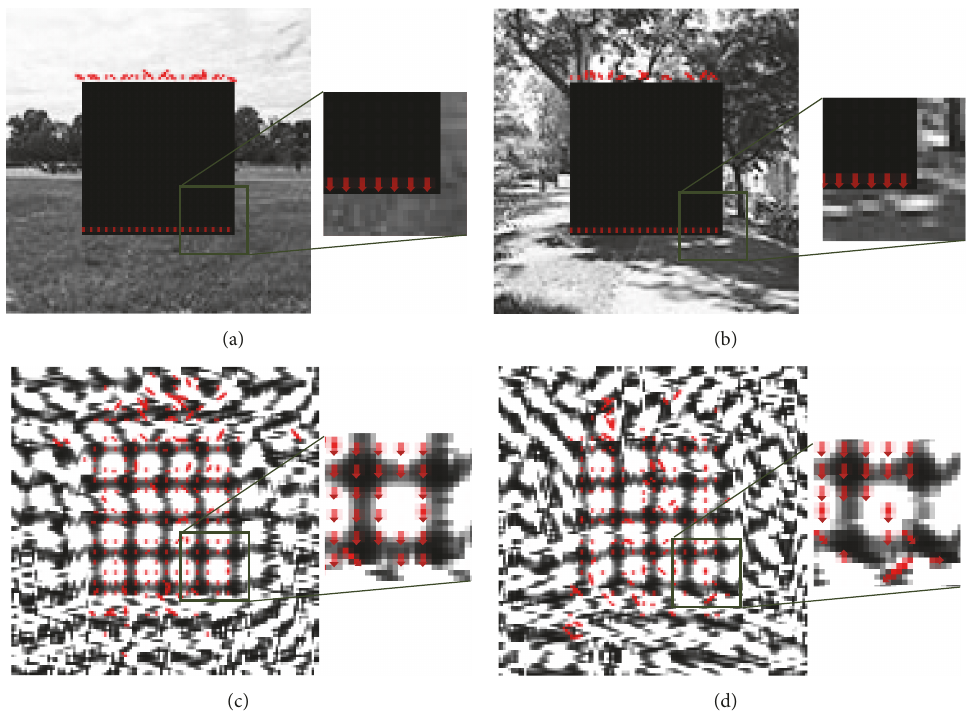
Figure 4: Simulations of an object movement corresponding to one pixel and subsequent detection of motion vectors depicted in red. ((a) and (b)) Motion vector results using a conventional block-matching algorithm; ((c) and (d)) corresponding results using the proposed RD-based method and hardware.